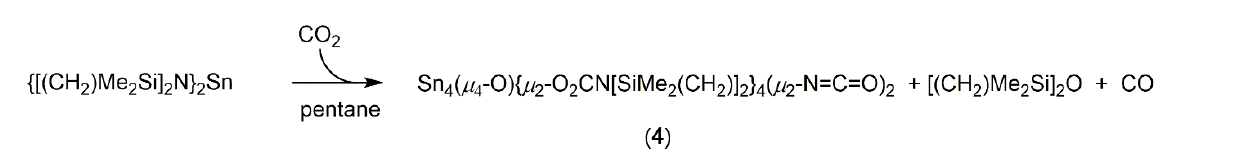
Figure 3. Molecular structure of 4 , adapted from [50] (MERCURY view). Hydrogen atoms are omitted for clarity (Sn light blue, O red, N dark blue, C grey, Si light yellow). In 2011, continuing their study on the reactivity of silyl-substituted tin(II) amides to- wards heteroallenes, Kemp et al. reported the interaction of CO 2 , OCS and CS 2 with (Me 2 N) 2 Sn leading to the formation of insertion products characterized as bis-( N , N -dime- thylcarbamato)tin(II), bis( N , N -dimethylthiocarbamato)tin(II), and bis( N , N -dimethyldithi- ocarbamato)tin(II), respectively [52]. Thus, (Me 2 N) 2 Sn in hexane solution reacts quickly with carbon dioxide, at room temperature and under atmospheric pressure, to give with a yield almost quantitative, the new complex [(Me 2 NCO 2 ) 2 Sn] 2 ( 5 ) (Scheme 14). The au- thors describe the reaction as exothermic. In the solid-state, compound 5 is organized as a dimer involving two types of carbamato ligands: bridging and terminally ( η 2 -chelating) coordinated to Sn. From a supramolecular point of view, the existence of intermolecular interactions Sn···O [2.8499(18) Å] between neighboring dimers and involving one oxygen atom of terminal carbamato ligands, leads to the propagation of a polymer chain (Figure 4). The coordination geometry of tin atoms can be viewed as a highly distorted trigonal bipyramid. In solution, the 119 Sn NMR spectrum exhibits only one resonance at δ –613 ppm. In the 13 C { 1 H} NMR spectrum, the carbamato carbon also displays only one signal, not making it possible to differentiate the bridging and terminal modes highlighted in crystals of 5 . Scheme 14. Reaction scheme leading to Compound 5 , data from [52].